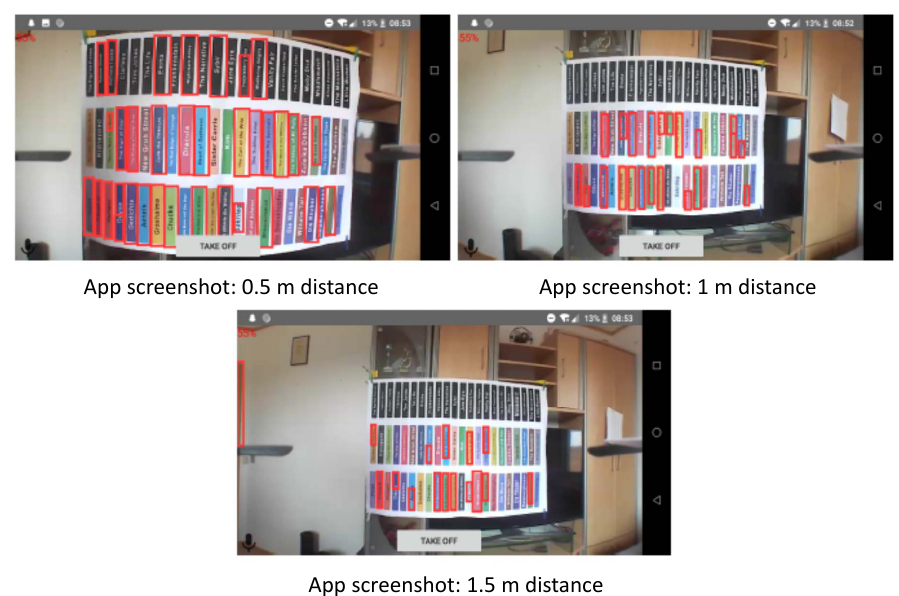
Figure 5. Visualization of book detection results marked as red rectangles, observed at three different distances.